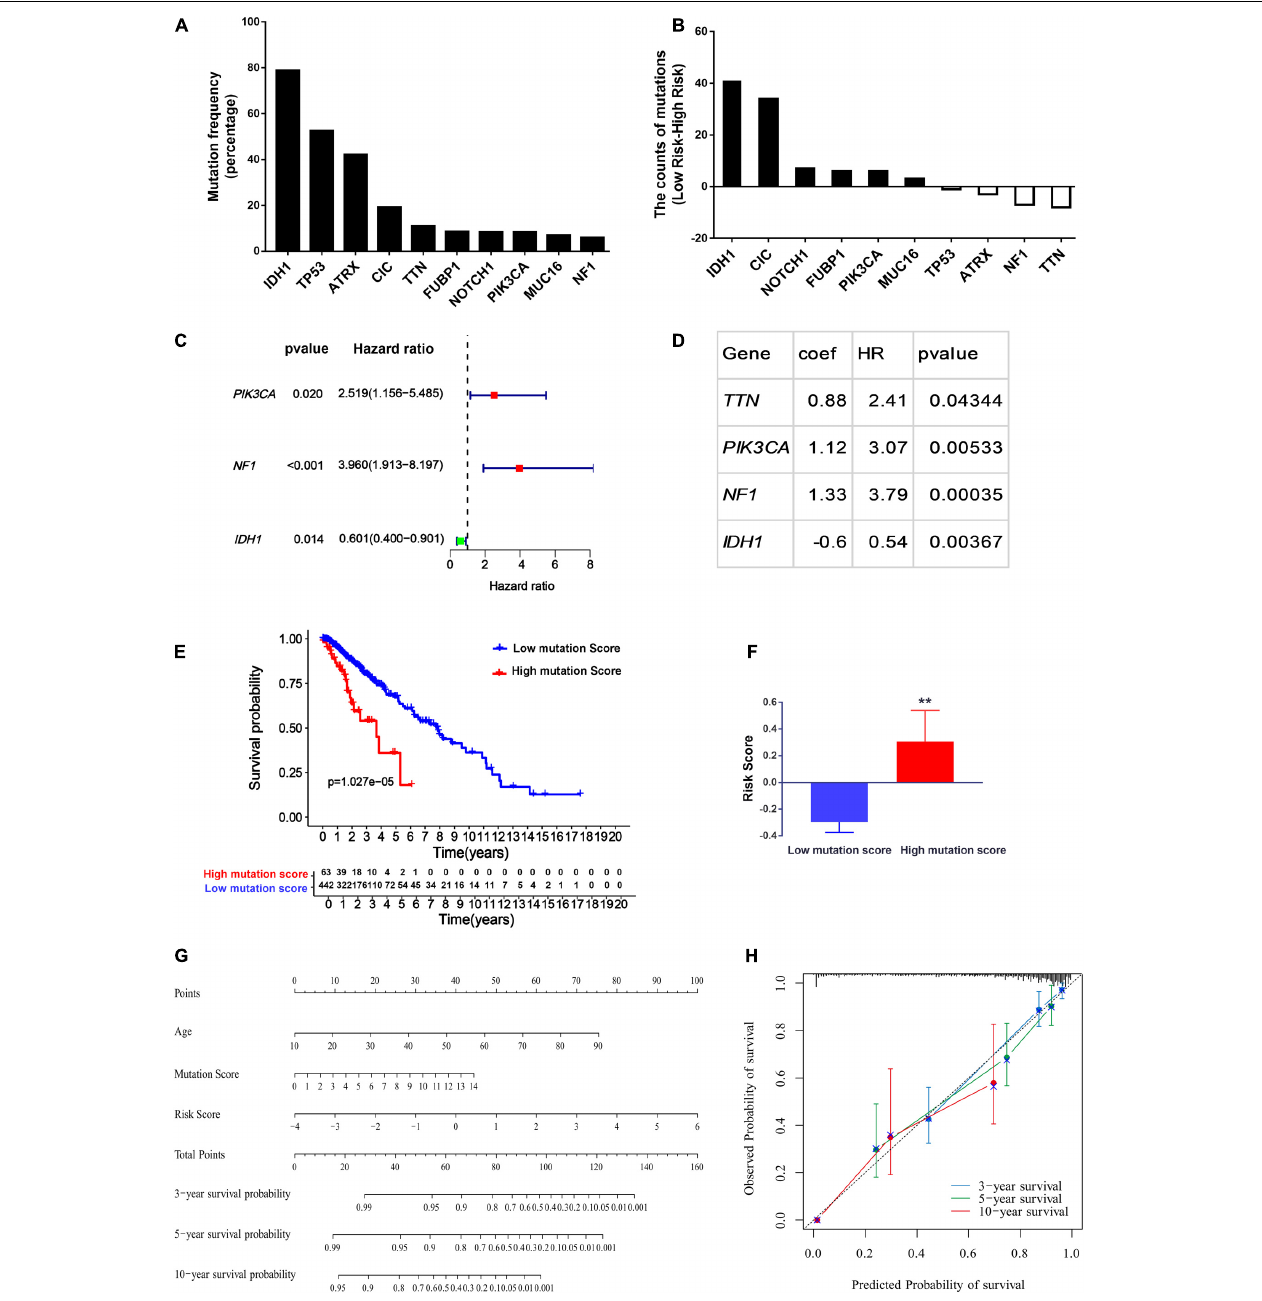
FIGURE 7 | Construction of the nomogram for predicting the overall survival of LGG patients. (A) Top ten genes with the highest mutation rates in the LGG patients obtained from cBioPortal. (B) The difference of mutation numbers between high-risk and low-risk groups. (C,D) Univariate Cox regression hazard analysis (C) and Multivariate Cox regression model (D) for top ten mutated genes in LGG. (E,F) The association of mutation score with the overall survival (E) and the ERG risk signature in LGG patients (F) . (G) Calibration plots for the nomogram. (H) Prognostic nomogram for LGG patients. ** P <